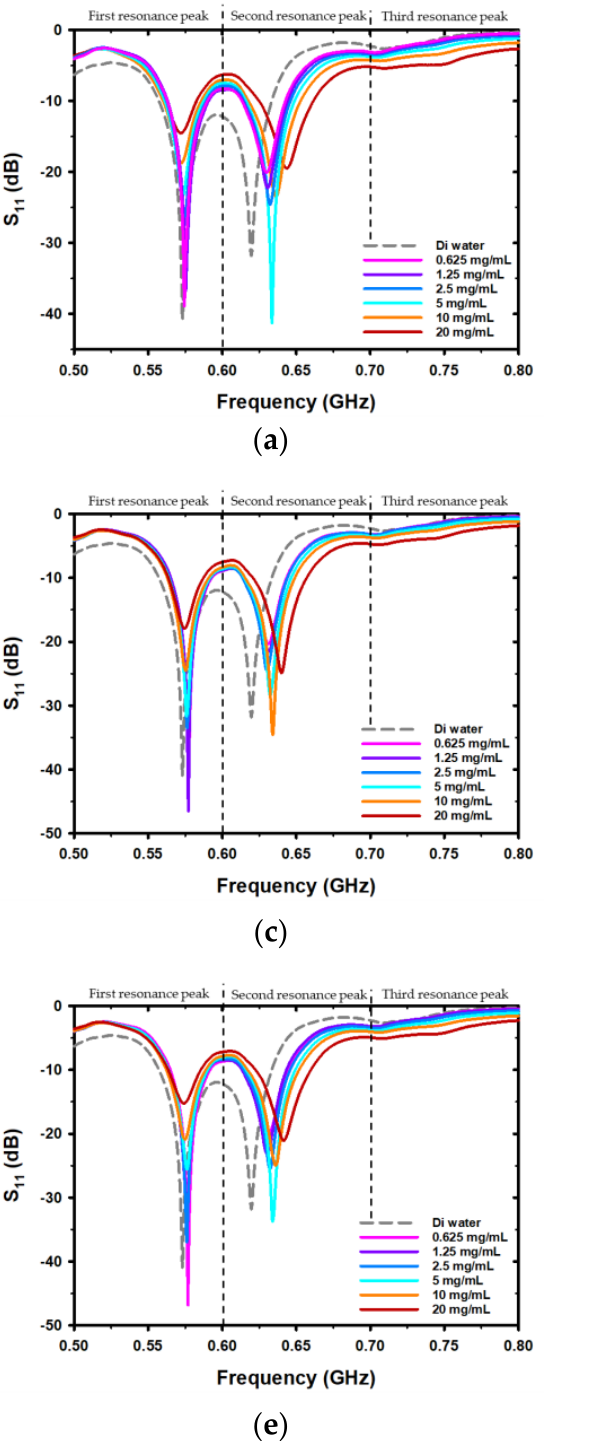
Figure 3. The reflection coefficient spectra in the frequency range of 0.5 GHz to 0.8 GHz are divided into three ranges, consisting of the first, second, and third resonance peaks for different concentra- tions of ( a ) sodium chloride (NaCl), ( b ) potassium chloride (KCl), ( c ) magnesium chloride (MgCl 2 ), ( d ) calcium chloride (CaCl 2 ), and ( e ) sodium carbonate (Na 2 CO 3 ).